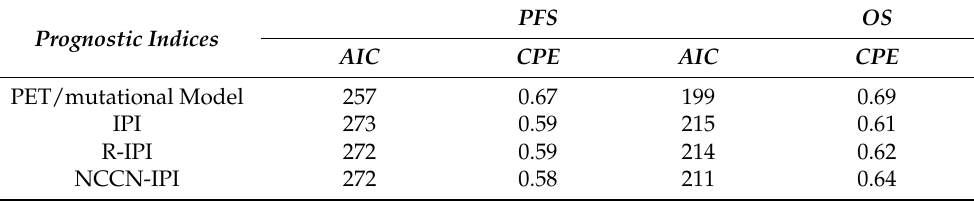
Table 5. Comparison of international indices with integrative PET model derived from the classification